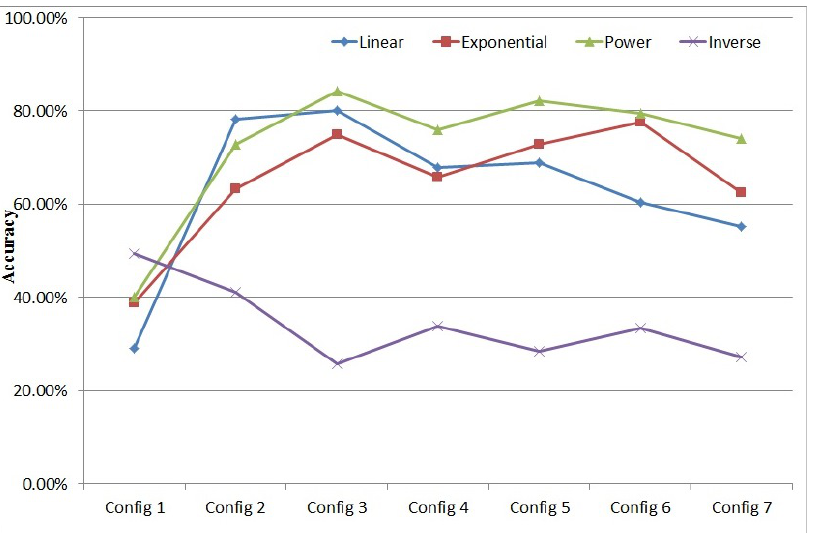
Figure 8. Efficiency of convolution and pooling